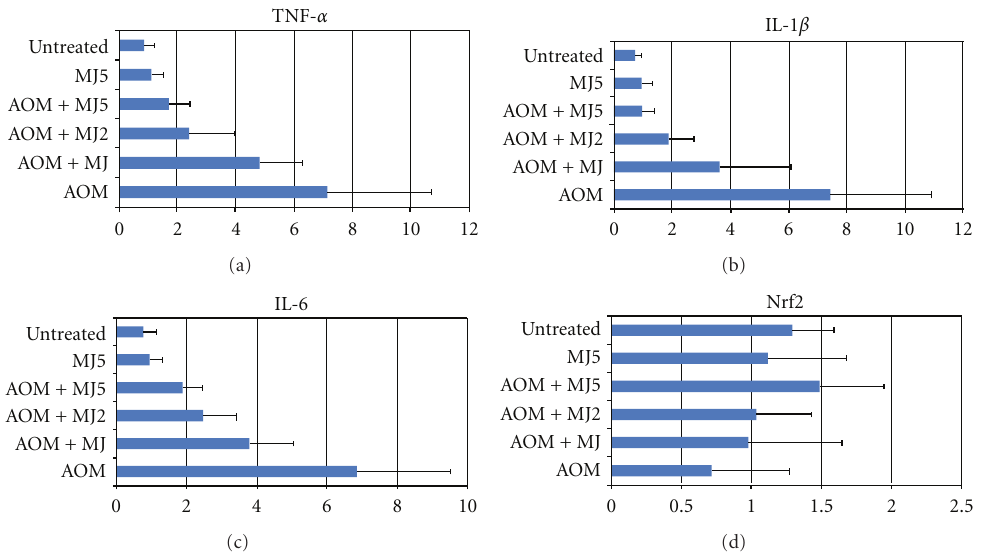
Figure 9: MJs lower mRNA expression of proinflammatory cytokines in the colonic mucosa of rats that received AOM at week 4 of the